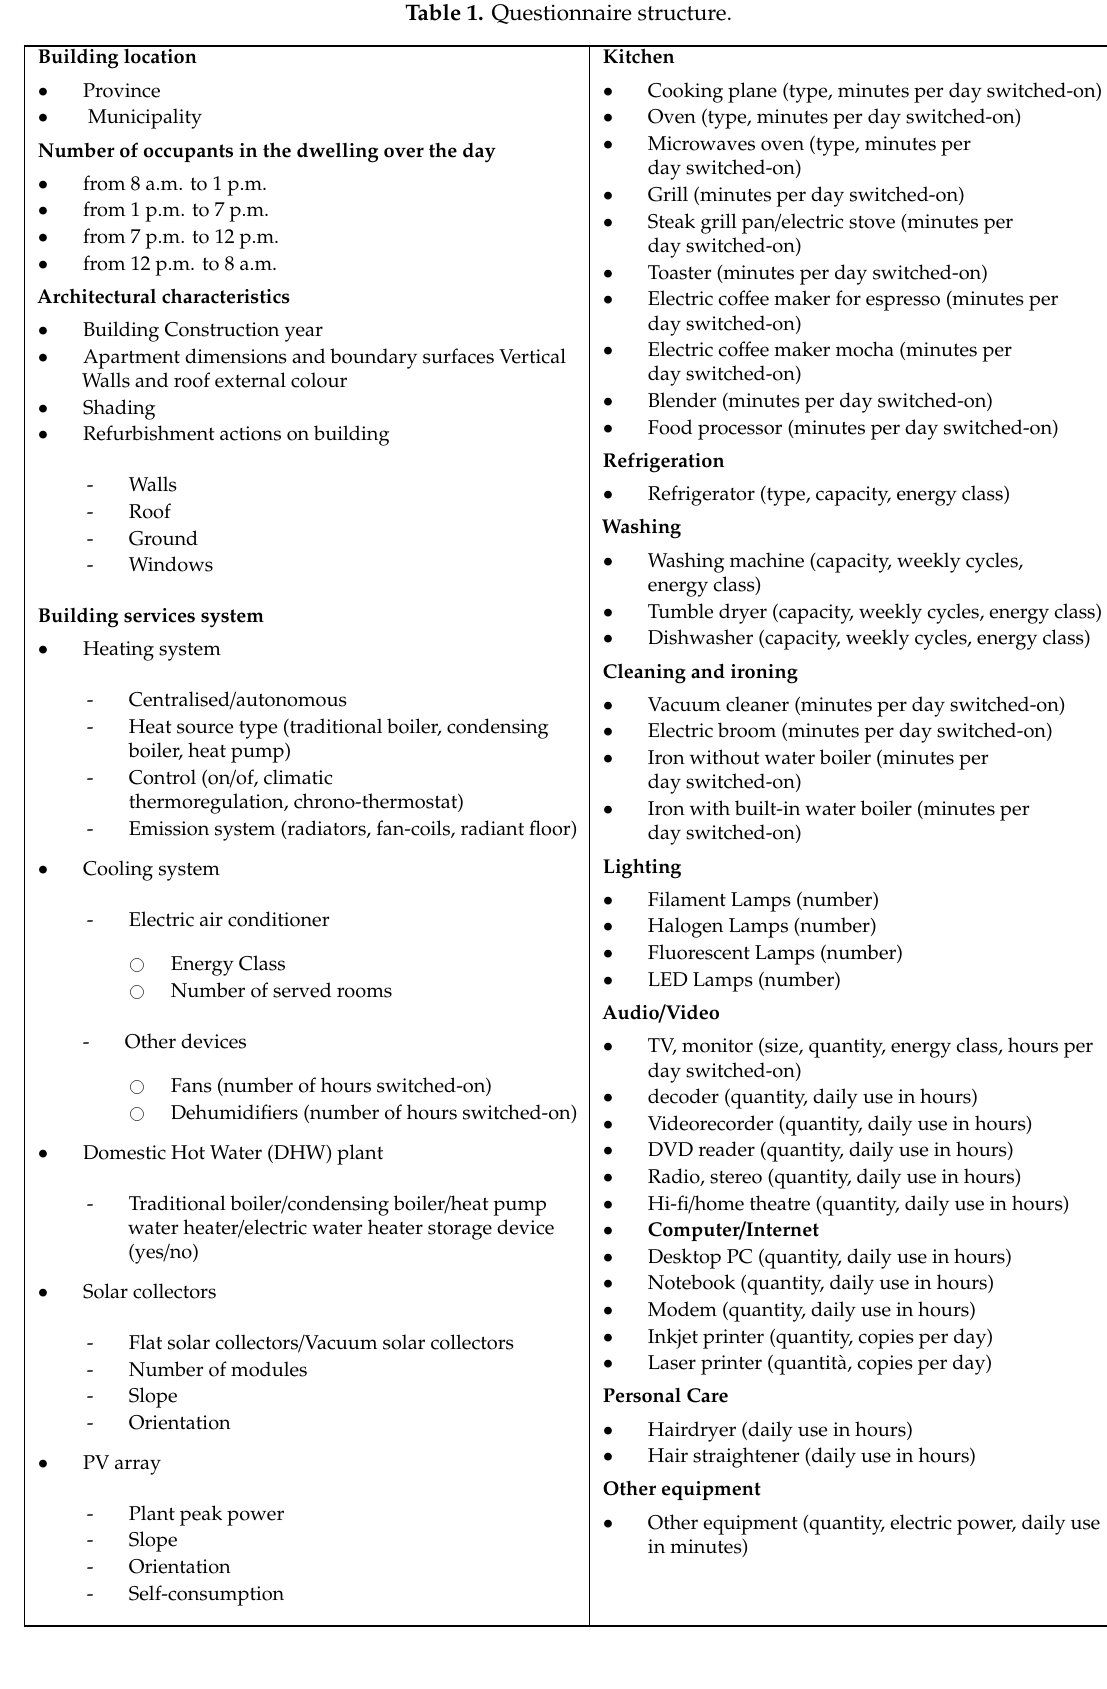
Table 1. Questionnaire